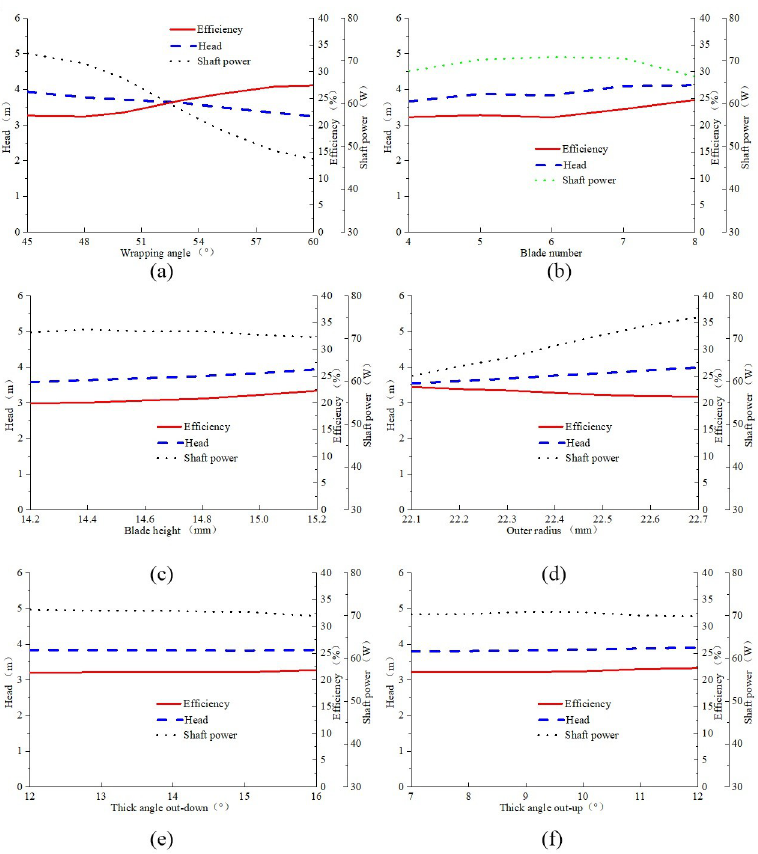
Fig 6. Influence of impeller geometric parameters on pump head and efficiency: (a) wrapping angle; (b) blade number; (c) impeller height; (d) impeller radius; (e) Thick angle out-down; (f) Thick angle out-up.